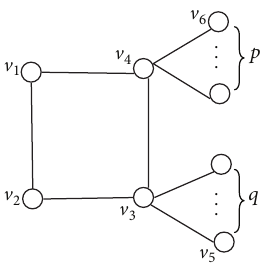
Figure 4: The graph 𝐺 3 (𝑝,𝑞)